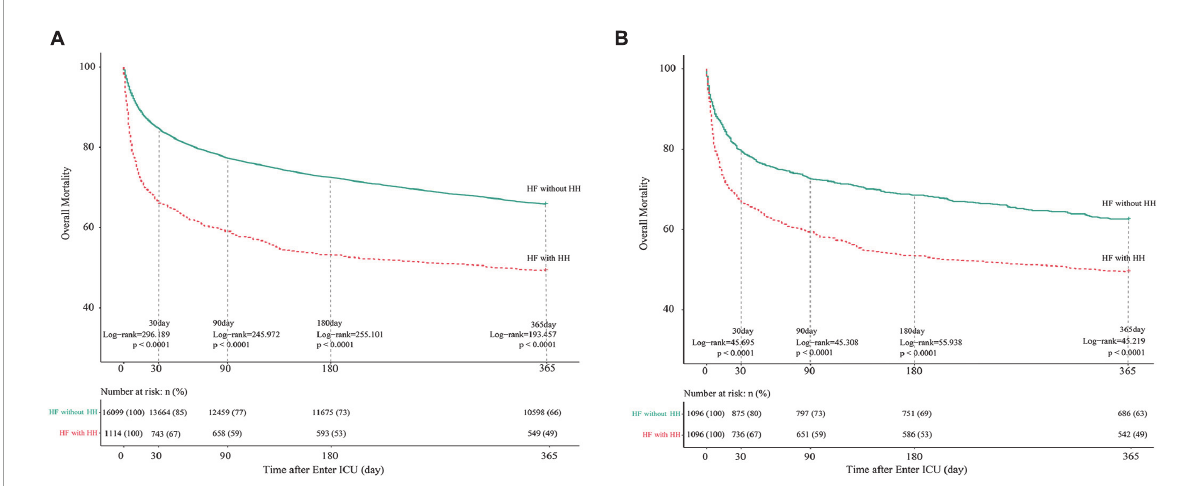
FIGURE1 Kaplan-Meier survival curves of HF patients with and without HH. (A) Before PSM; (B) after PSM. The differences between the HF with- and without-HH groups were measured by the two-side log-rank test with a P -value < 0.05. HH, hypoxic hepatitis; HF, heart failure; PSM, propensity score